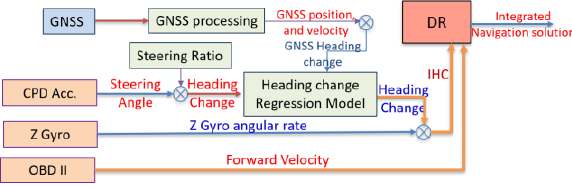
Figure 5. Proposed DR navigation system scheme based on CPD heading change, vehicle information, and onboard z- gyroscope.